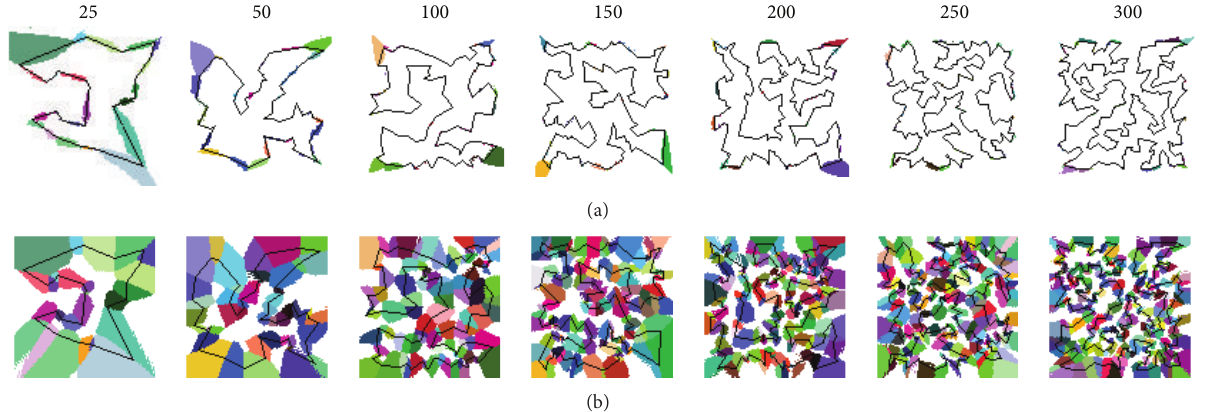
Figure 4: Examples of ASA and SASA for TSP instances with different numbers (the top line) of uniformly distributed cities, 𝑋 = 1, 100 × 1, 100 .